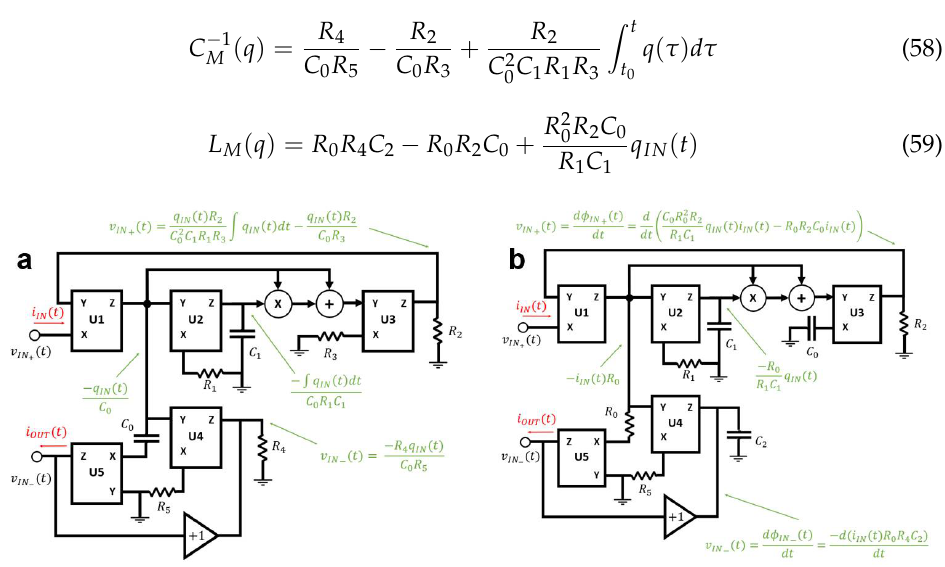
Figure 20. Universal circuit proposed by Zhao et al. [63] for the emulation of floating memcapacitors ( a ), and floating meminductors ( b ). ( a ), and floating meminductors ( b ).